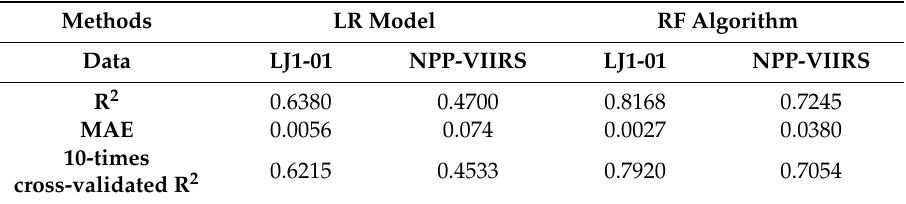
Figure 5. Scatter diagrams between the true CEI and the predicted CEI. ( a ) RF model using LJ1-01 NTL; ( b ) LR model using LJ1-01 NTL; ( c ) RF model using NPP-VIIRS NTL; and ( d ) LR model using NPP-VIIRS NTL. Table 6. Comparison of accuracy between the LR and RF